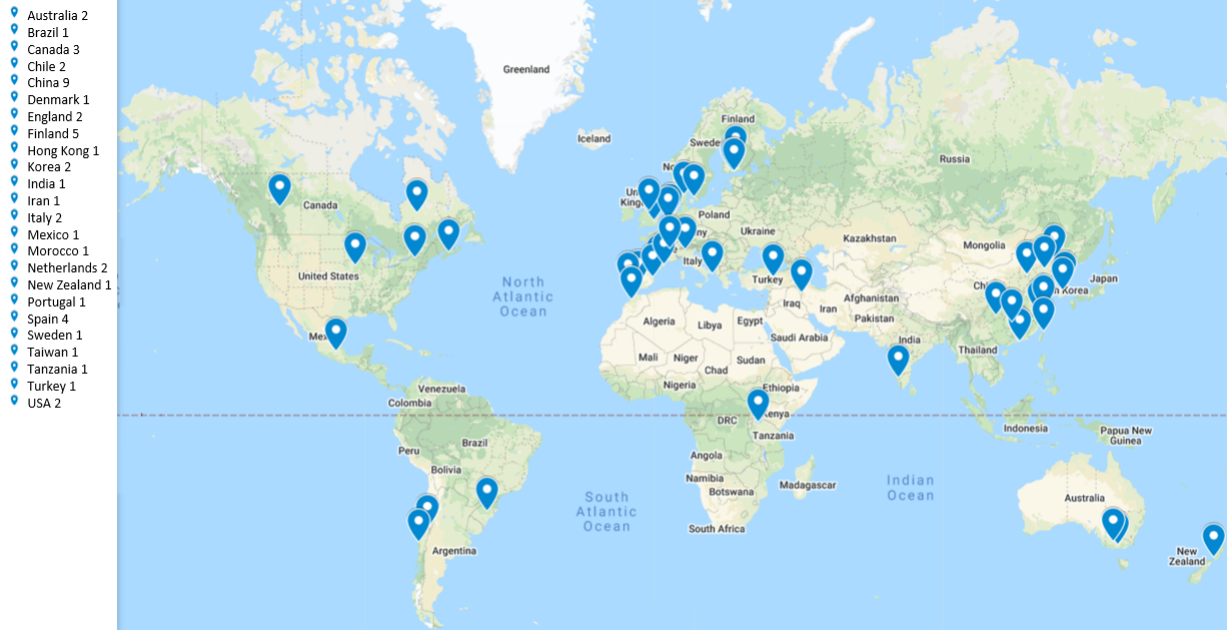
Figure 2. The locations and number of reviewed urban wetlands in different